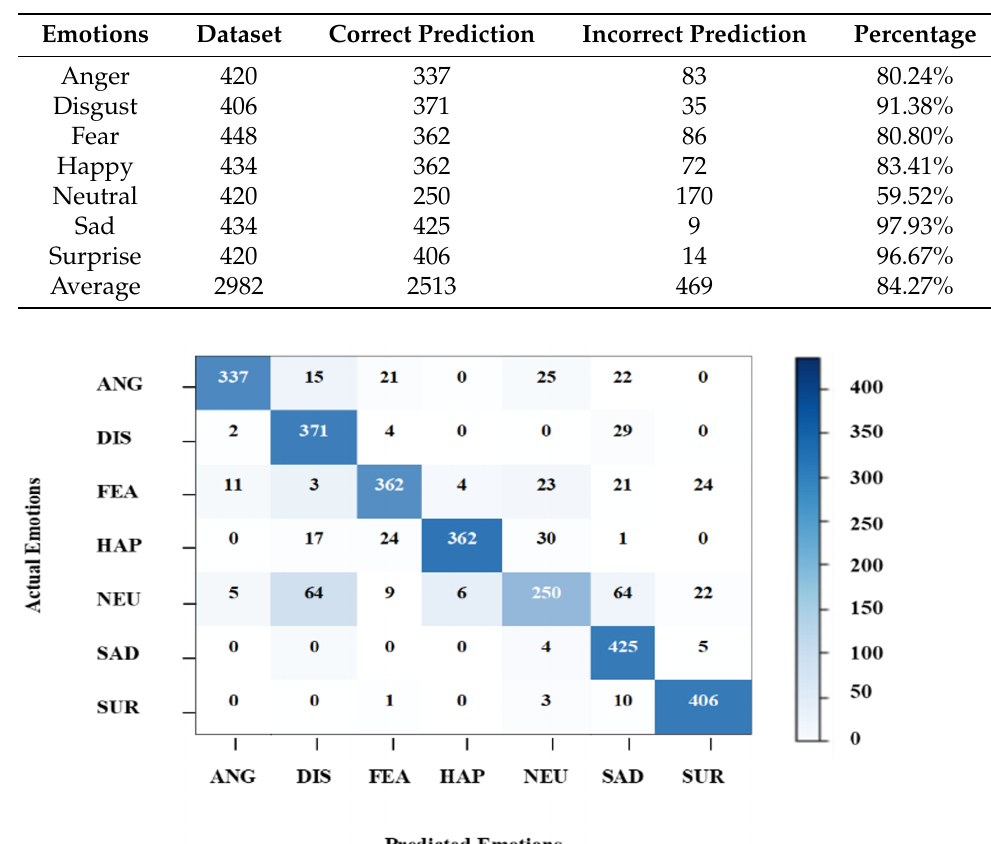
Table 21. Cross dataset testing result of the proposed model after 10 epochs.